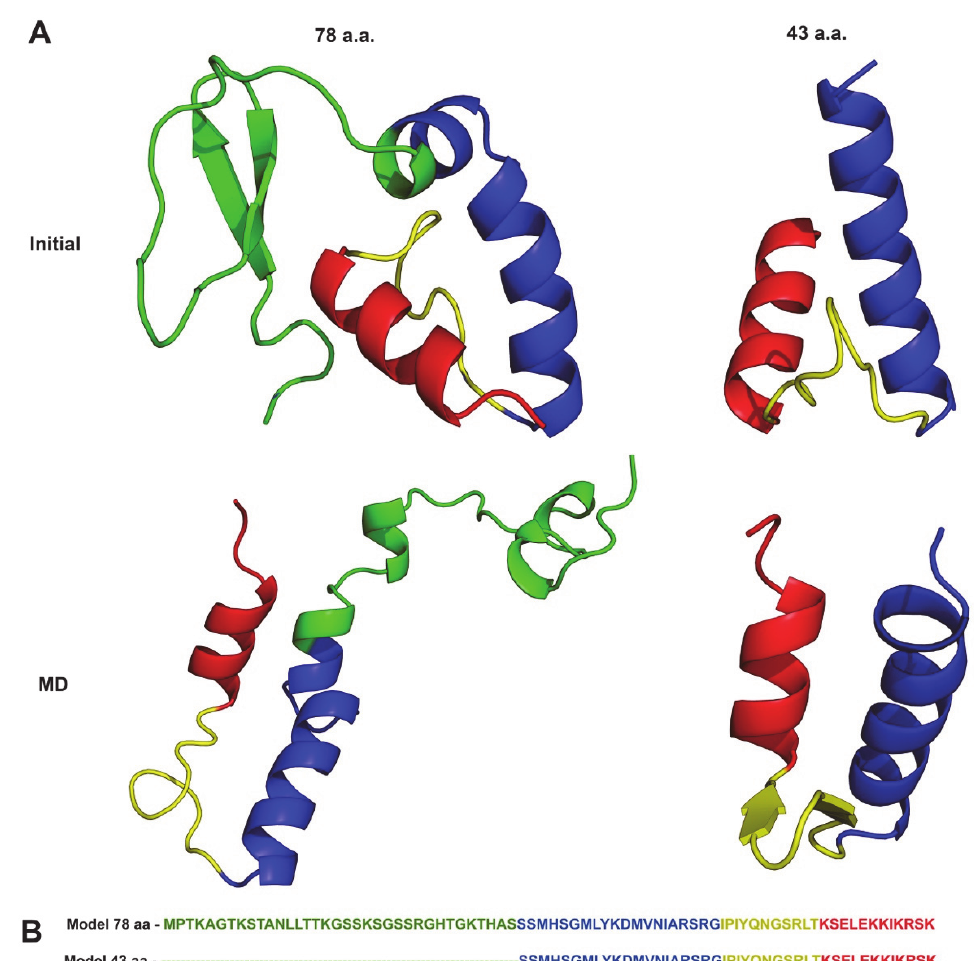
Figure 1. ( A ) Structural representation of the ab initio models (initial) and of the most representative (central) conformations obtained from MD simulations of wt:p10. ( B ) a.a. sequences of both models. The full and partial a.a. sequences of both models are colored with the same color scheme used in the structures.